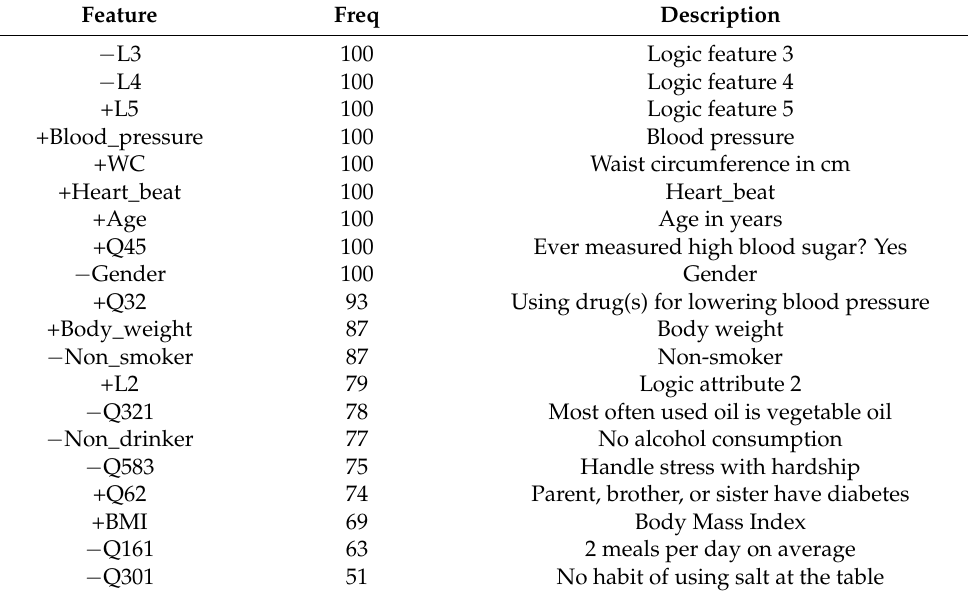
Table 4. Selected features with LASSO on the dataset with binary, numeric, and logic